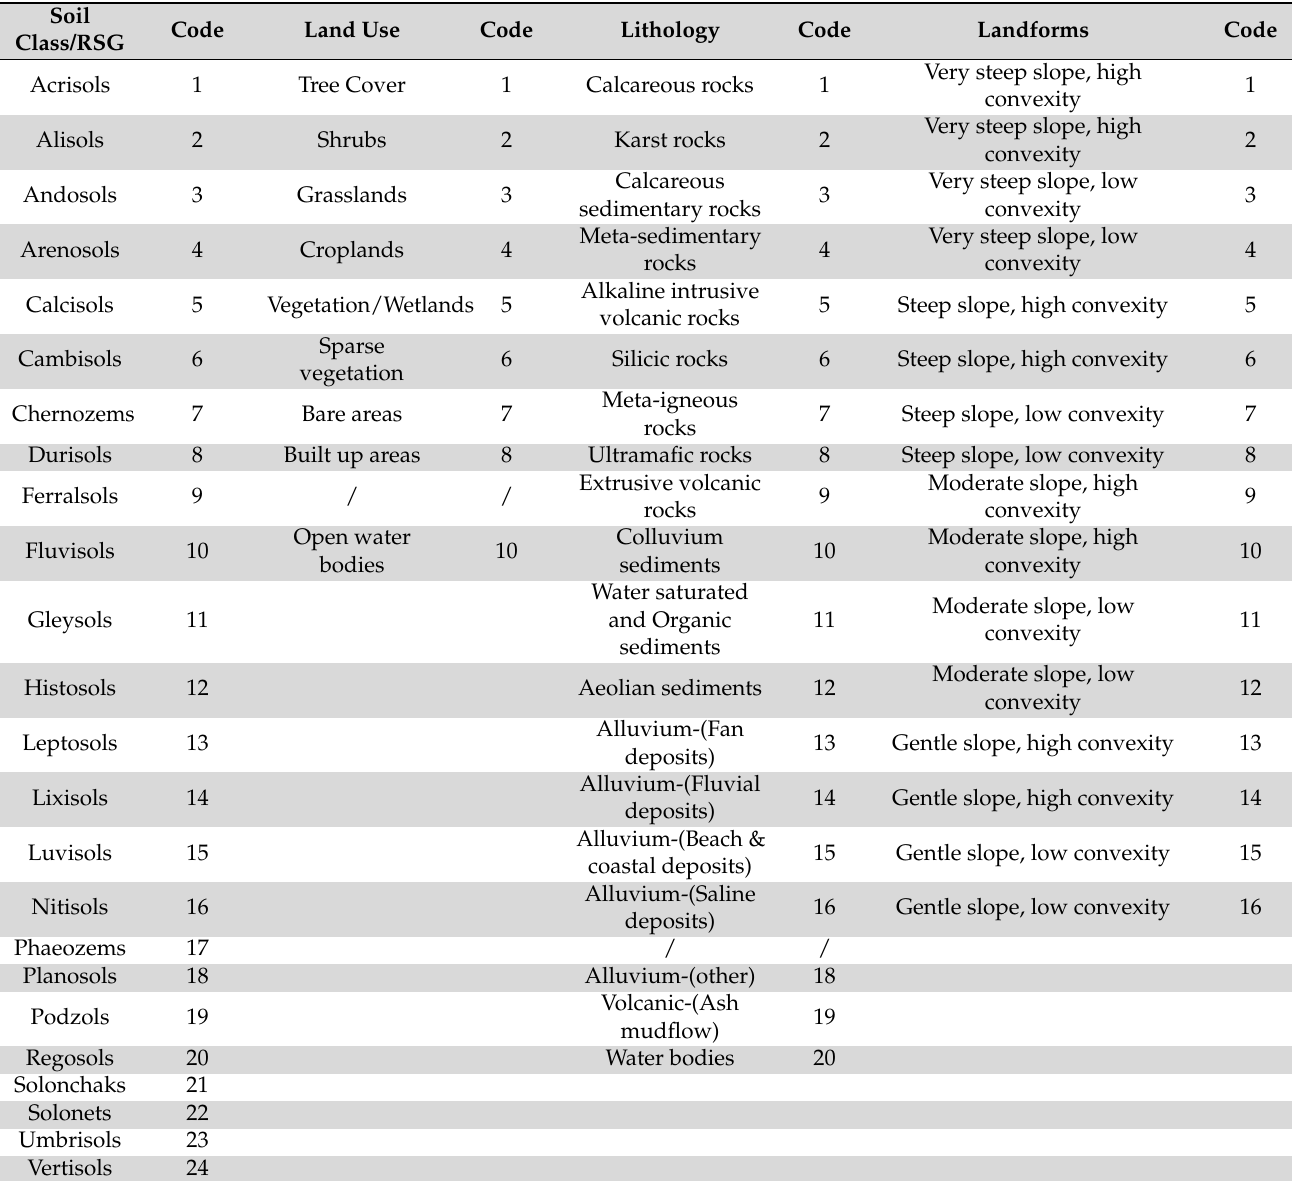
Table 2. Definition of classes for categorical